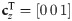
Graphs for controllability and observability analysis.(a) Graph of the pair Df, bz] where bz = [0 0 1]T is the input vector. (b) Graph of [(Df)T, cz], the dual of (a), where czT=[001] is the input vector. (c) Graph of [Df, cz] used with the “dual interpretation”. Dashed lines indicate non constant connections due to nonlinearities. Notice the similarity with the graph in Fig 1a.